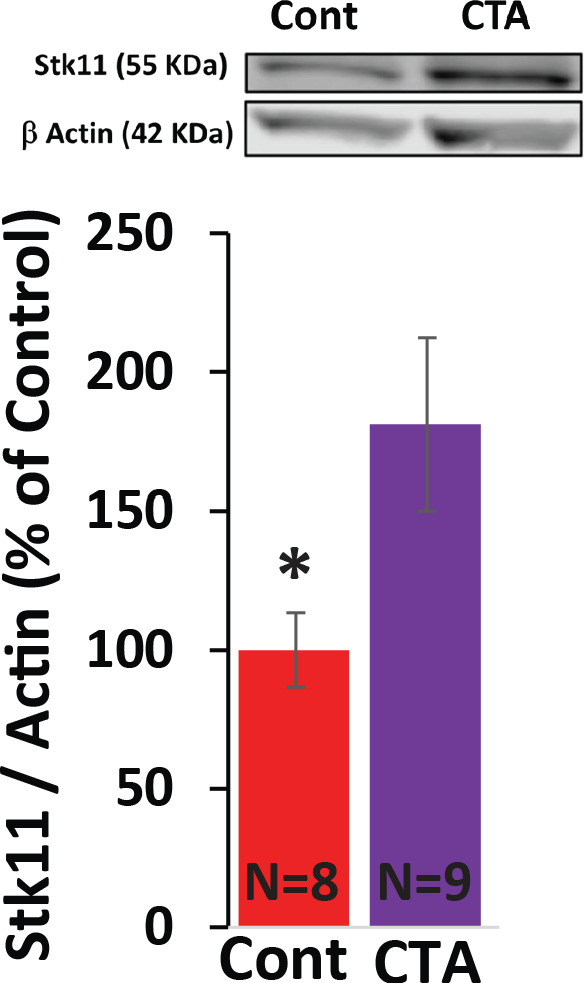
STK11 protein expression following CTA training.YFP-H mice were trained for CTA or received a taste control and 4 hr later the anterior BLA (guided by YFP expression) was sub-dissected and used for immunoblotting with antibodies raised against STK11 and actin (as loading control). CTA increased the expression of STK11 (t(15)=2.28; p=0.037, N = 8/9 per group). *p<0.05. See also Figure 2—figure supplement 2—source data 1.Figure 2—figure supplement 2—source data 1.STK11 protein levels in the BLA 4 hr following CTA training or taste control.This data relates Figure 2—figure supplement 2.